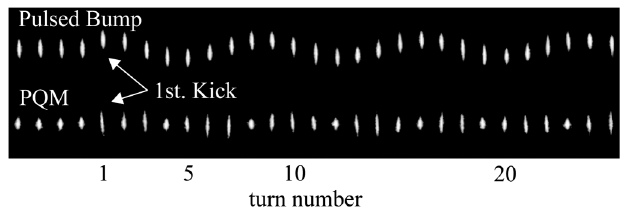
FIG. 4. Turn-by-turn stored beam profiles in pulsed bump injection (upper figure) and PQM injection (lower figure) moni- tored by a fast gated camera at the PF-AR. The horizontal axis represents a turn number and the vertical axis represents a horizontal